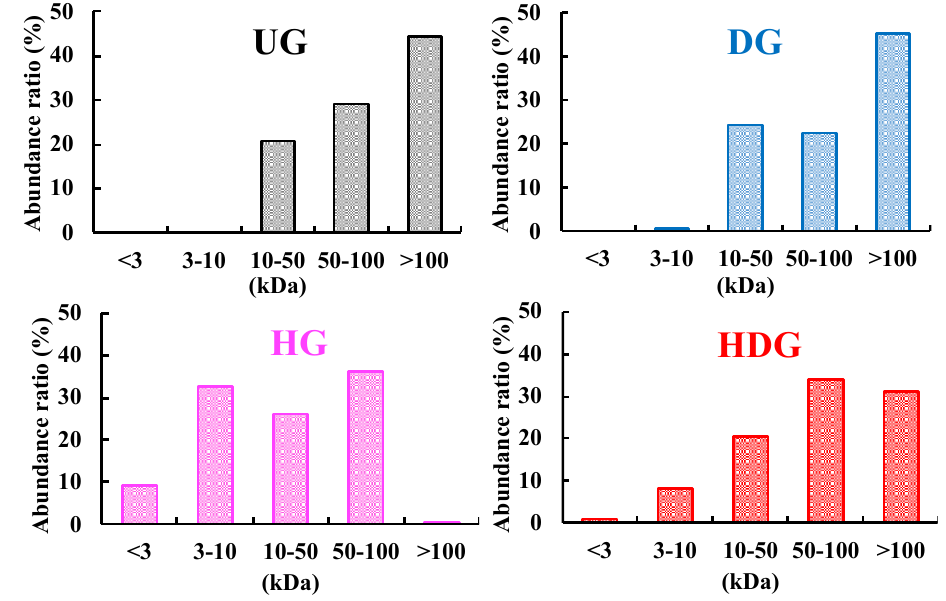
Figure 3. Molecular weight distribution of gliadins.